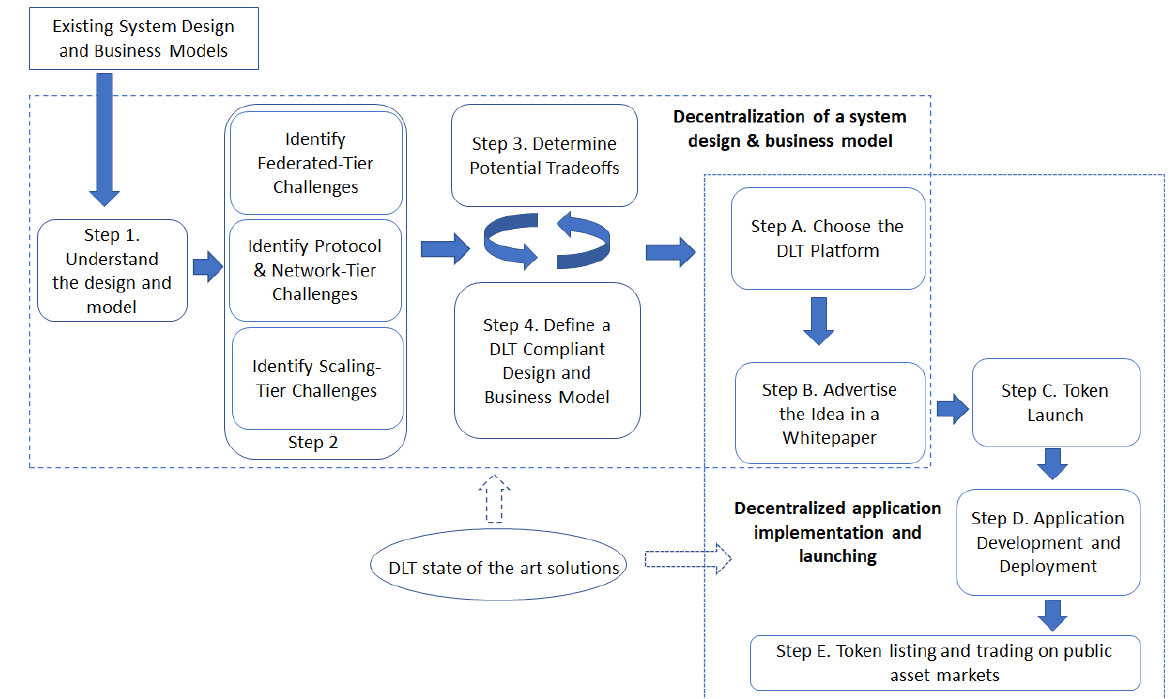
Figure 8. Decentralized application design and implementation steps.